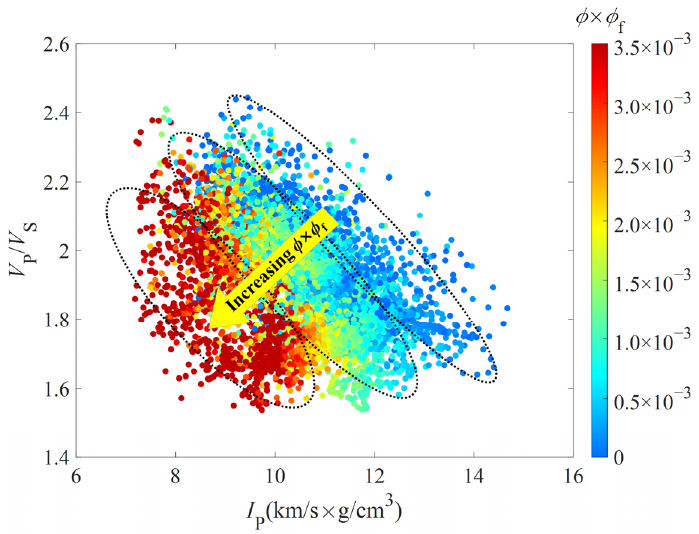
Figure 10. Cross-plot of V P / V S and I P color-coded by ϕ × ϕ f .